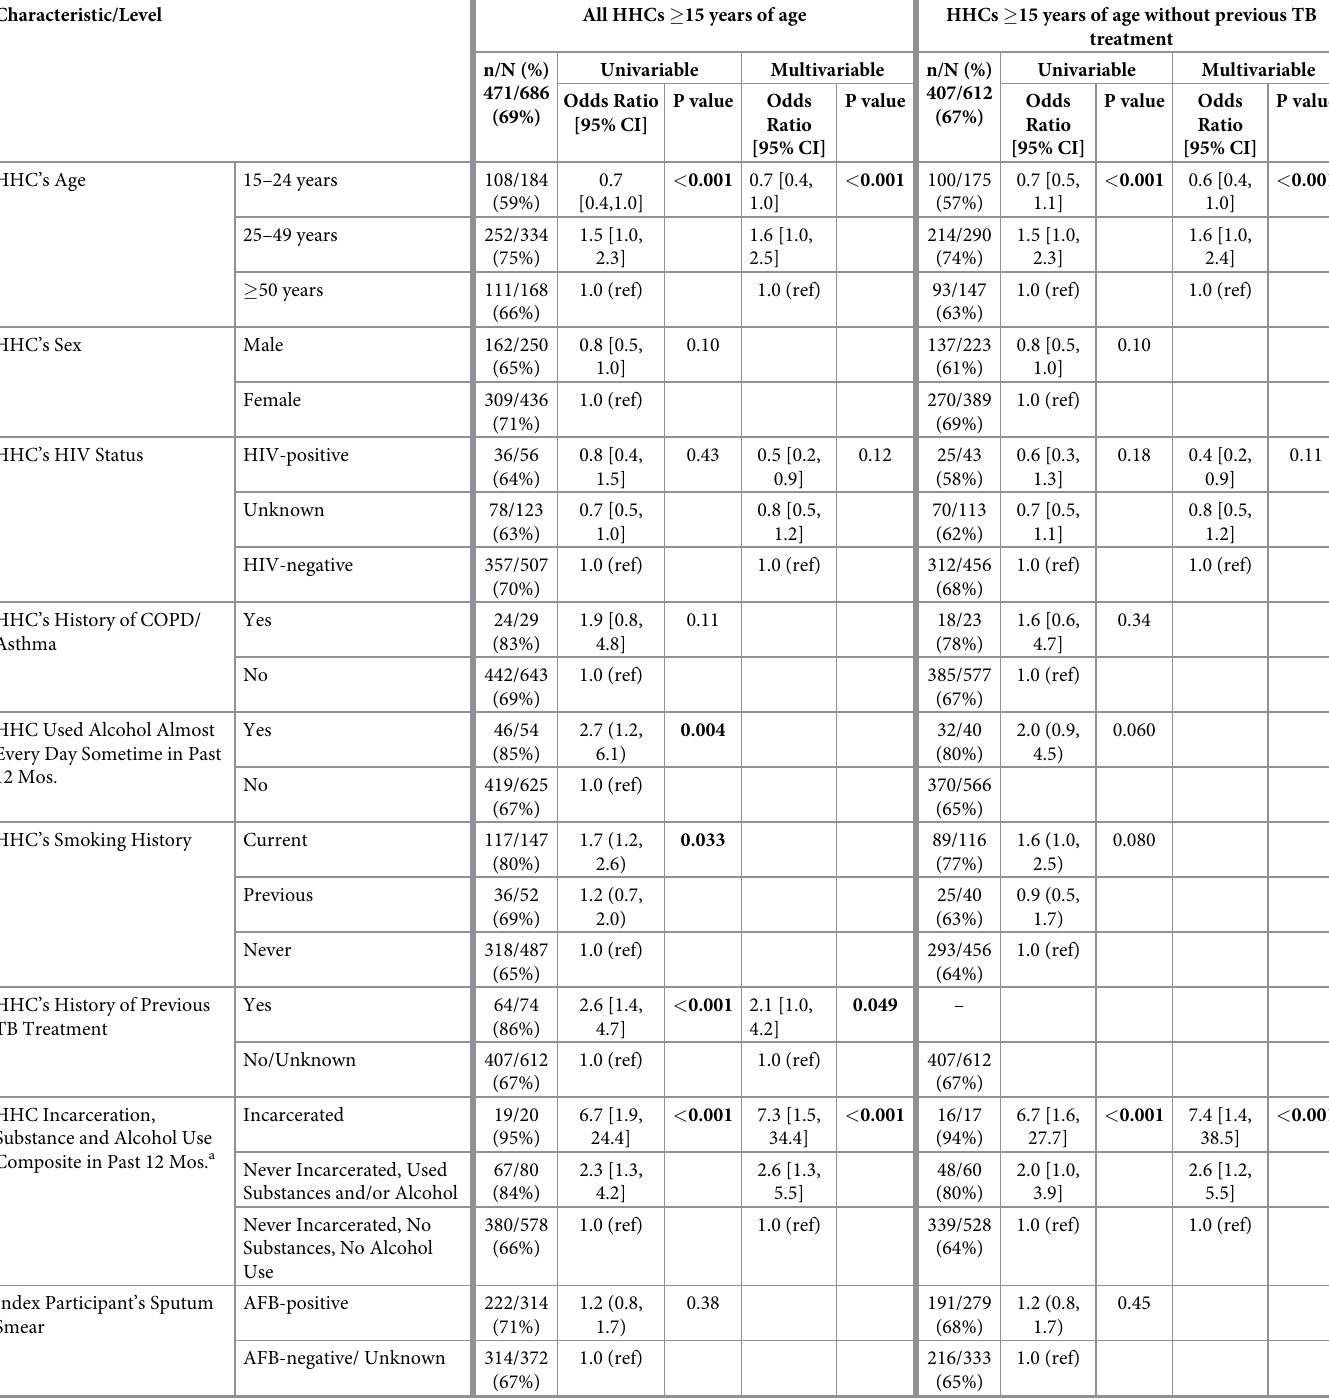
Table 2. Logistic regression modeling for Mycobacterium tuberculosis infection (positive IGRA) in household contacts � 15 years of age � .